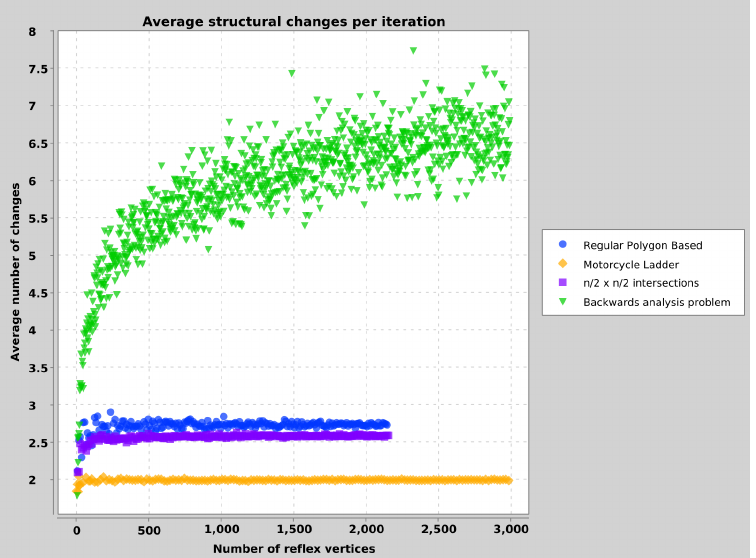
Figure 13. Average number of structural changes per insertion step, for specifically constructed